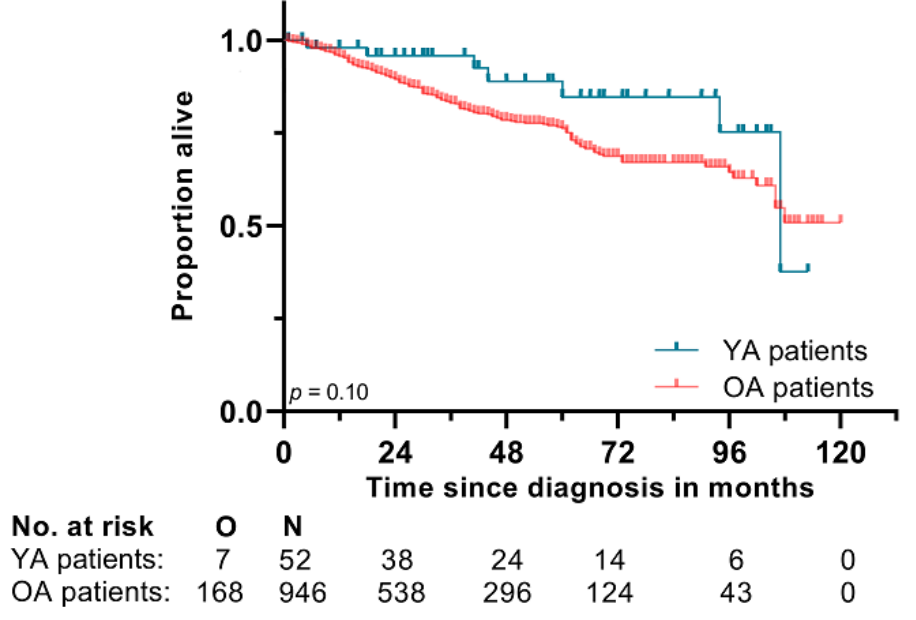
Figure 2. Overall survival curve of the young adult (YA) patients and older adult (OA) patients. O = number of observed events; N = number of patients at risk.